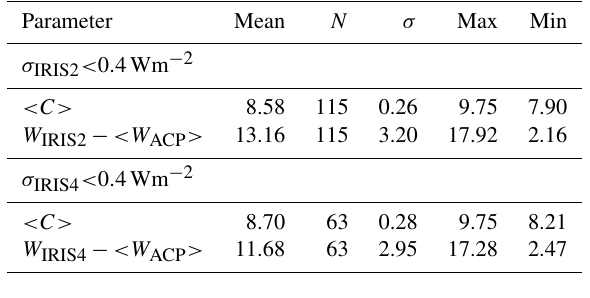
Table 7. Linear LSQ method results for ACP96 < C > using ε c = 0 . 0225, γ = 8 . 4 and τ = 0 . 977 and the difference between ACP96 and IRIS irradiances when coincident data were available ( W IRIS − <W atm > ). The first and second data rows concern periods when ACP96 and IRIS2 data were available; the third and fourth data rows concern periods when ACP96 and IRIS4 were available.